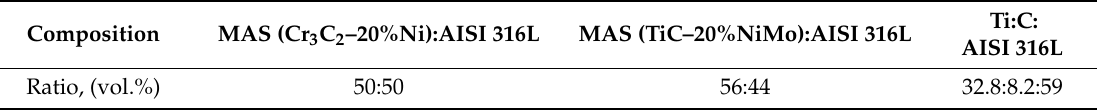
Table 2. Reinforcement to matrix ratio of the experimental